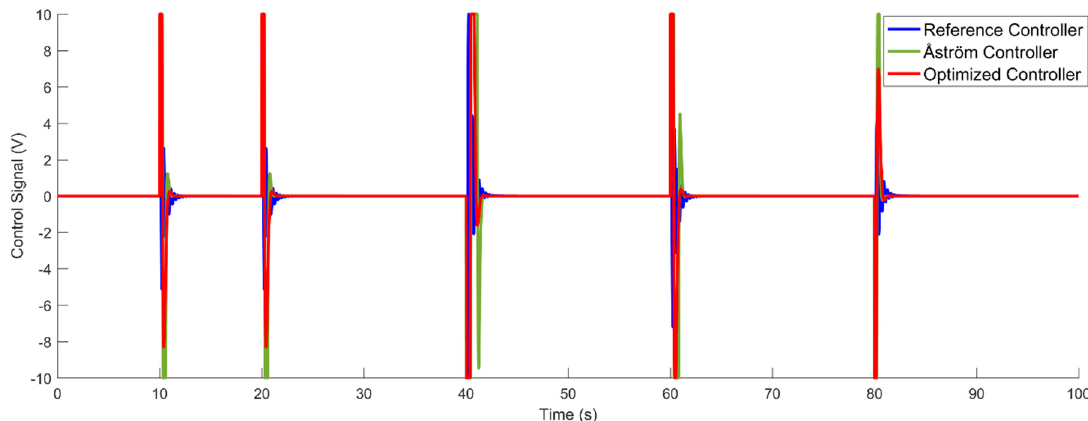
Figure 16. The control signal from different controllers for the reference changes.